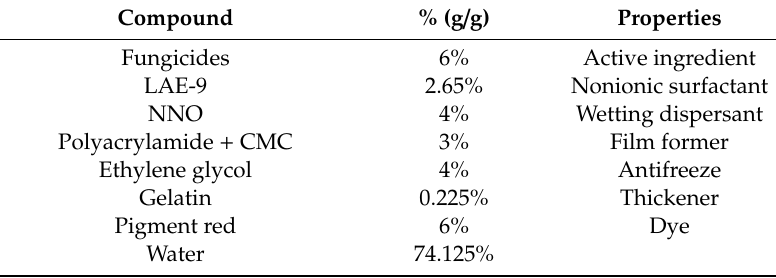
Table 3. The main components of seed